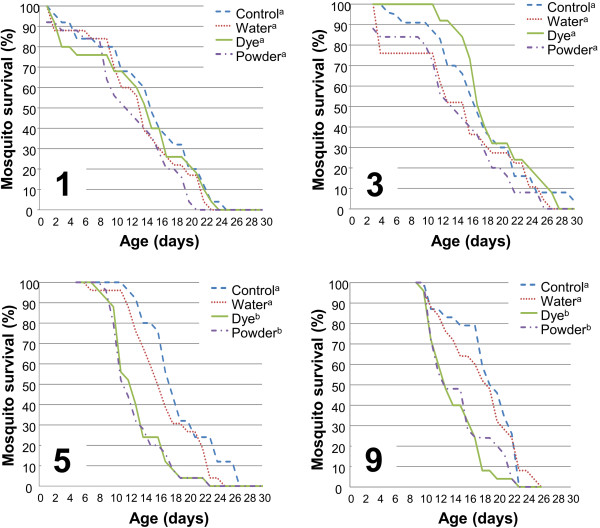
Effect of fluorescent dye and powder on the survival of A. gambiae. Mosquitoes were either non-treated (Control), sprayed with water (Water), sprayed with fluorescent dye dissolved in water (Dye) or treated with fluorescent powder (Powder). Treatments were applied 1, 3, 5 or 9 days after adults emerged from pupae. N = 25 for each treatment at each starting point. Data followed by different letters differ significantly at P < 0.05 (Kaplan-Meier).